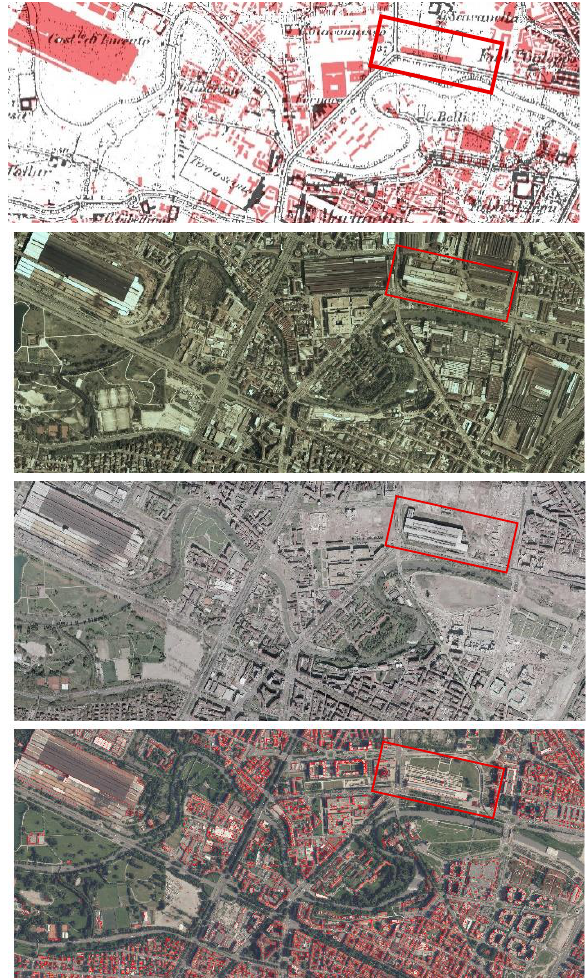
Figure 2. Multi-temporal geospatial data from Torino SDI Geoportal: 1880-1882 IGM, 1979, 2004,